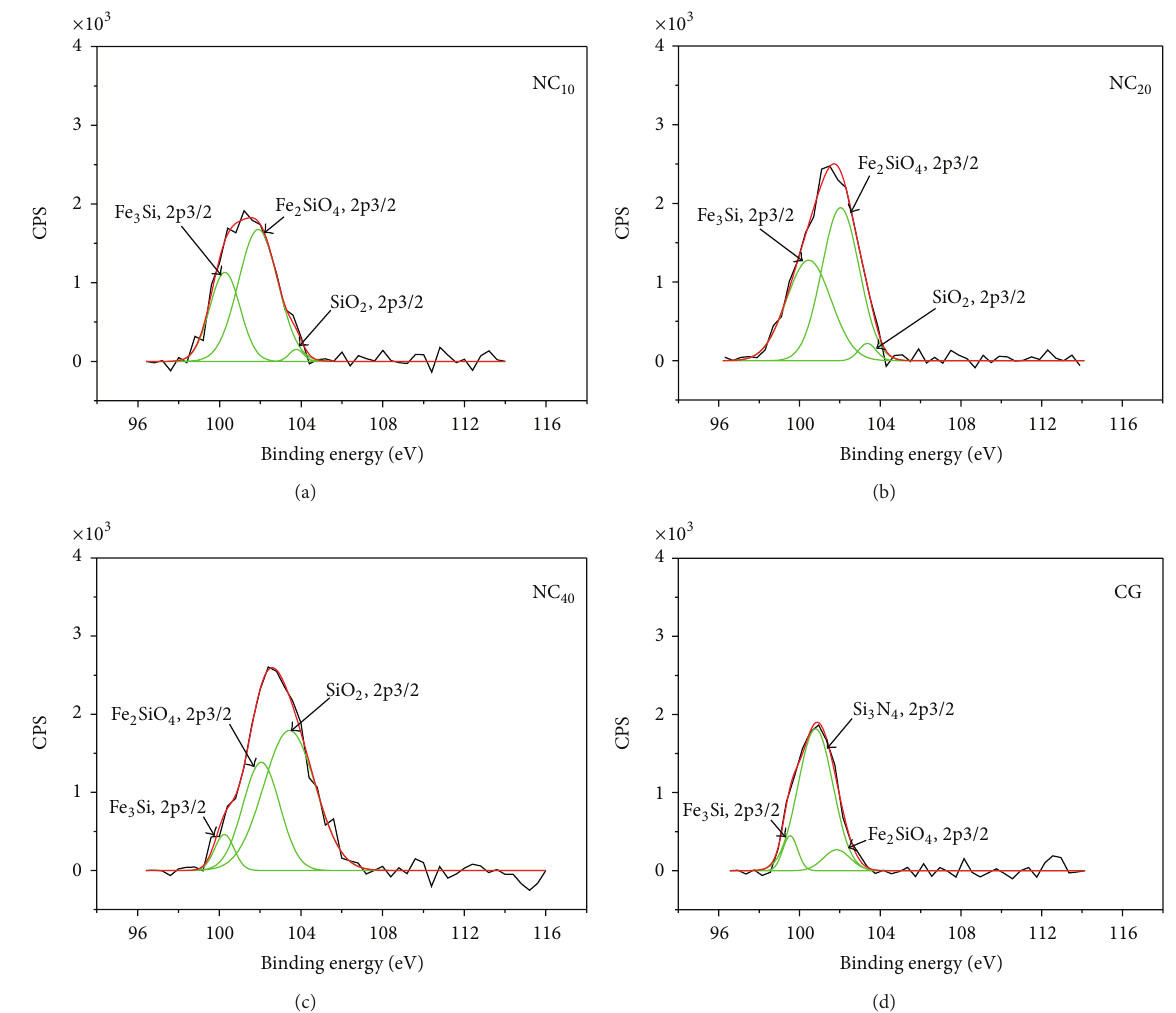
Figure 4: XPS spectra of Si2p of Fe 88 Si 12 alloys on the worn surfaces at a sliding speed of 0.08